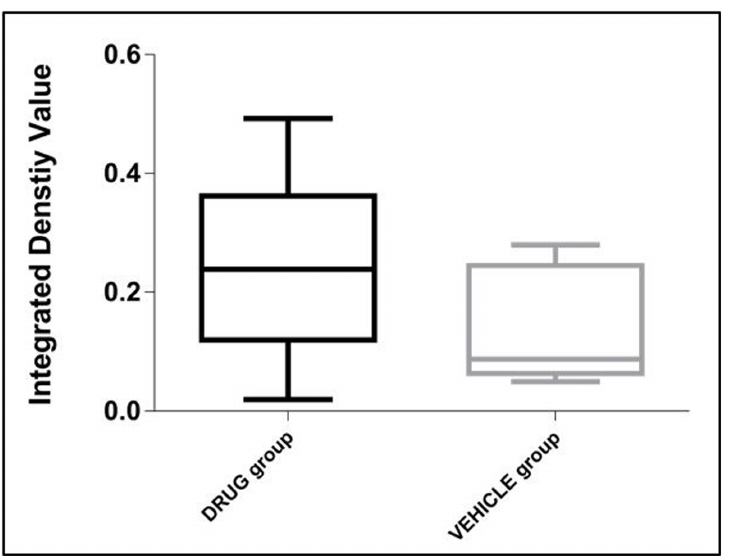
Fig 4. Gel zymography for MMP-9 levels. No significant differences were observed for MMP-9 levels between DP- 460 drug and VEH groups. MMP-9 levels were expressed as integrated density value of 92kDa lytic bands on zymographic gels. Data is represented as box plots, with the median and interquartile ranges (n = 10 rats per group).